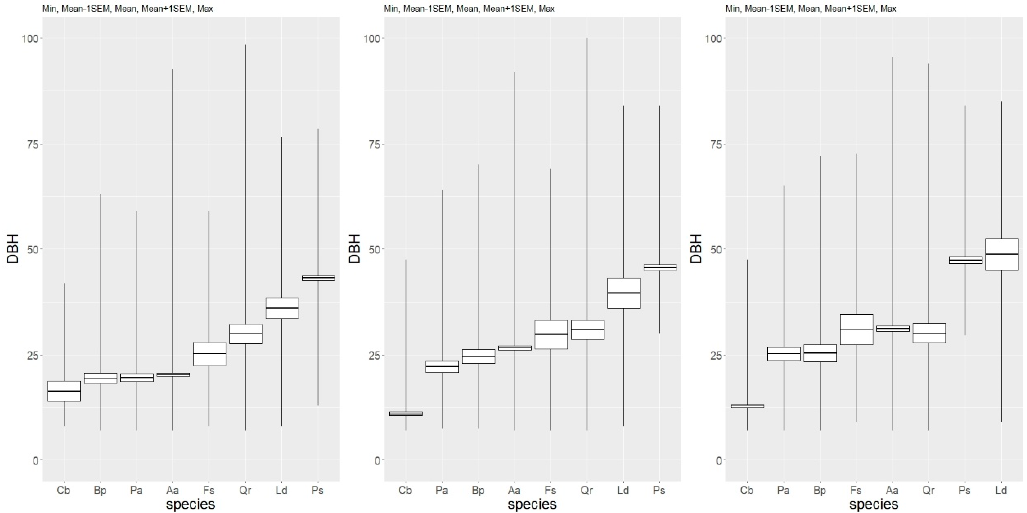
Figure 3. Boxplots for the diameter of tree species present in the multispecies, uneven-aged forest in 1993, 2006, and 2017 (from left to right) (ascending order).